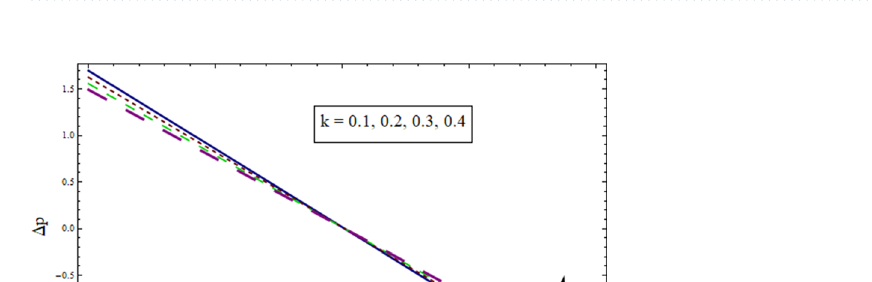
Figure 21. Δp for γ .